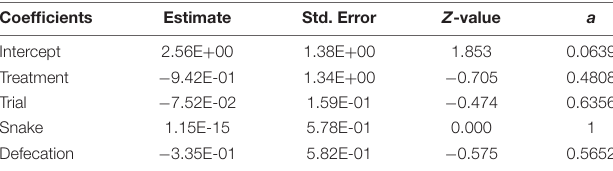
TABLE 2 | Logistic regression results from primary